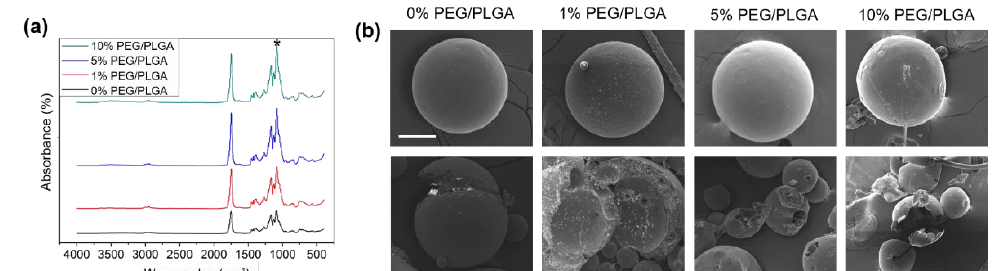
Figure 2. Fabrication and characterization of PEG/PLGA microspheres: ( a ) FTIR spectra of 0%, 1%, 5% and 10% PEG/PLGA microspheres. * represents the peak of the C – O – C bond from PEG; ( b ) SEM images of external and internal morphologies of the microspheres, where 0%, 1%, 5% and 10% are the mass ratios of the PEG/PLGA feed during preparation of microspheres. Scale bars: 100 µ m. Abbreviations: PEG, poly (ethylene glycol); PLGA, poly (lactic-co-glycolic acid).